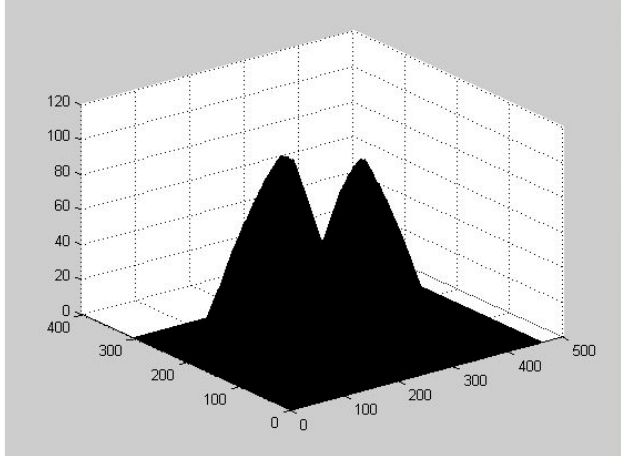
Figure 6. Three dimensional map of the distance function.